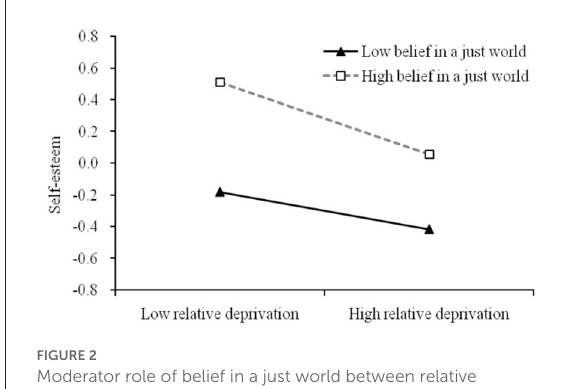
FIGURE2 Moderator role of belief in a just world between relative deprivation and